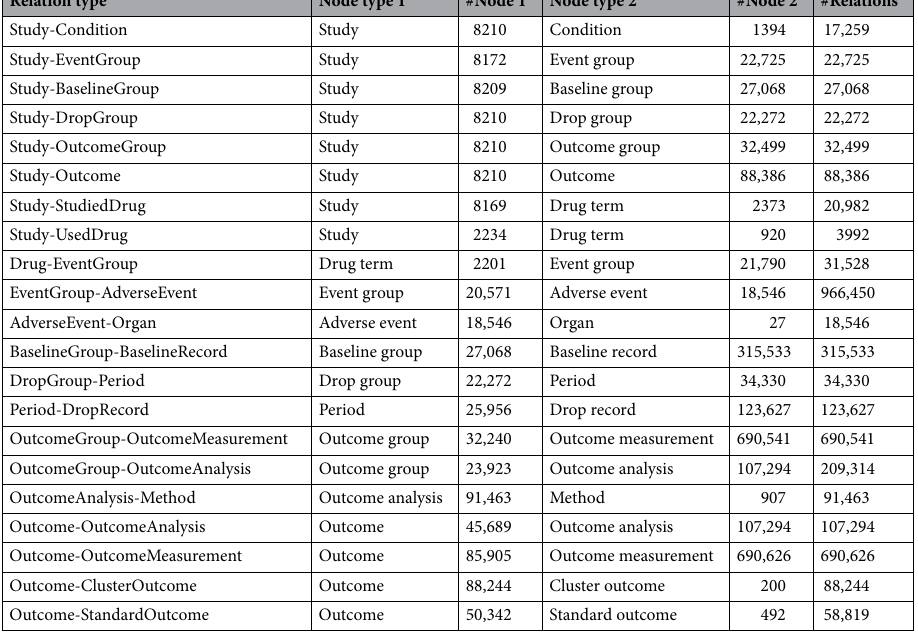
Table 2. Statistics of relation types in CTKG . Columns represent: “Relation type”: the type of relation; “Node type 1”: the type of head nodes in the relations; “#Node 1”: the number of unique head nodes with the relations; “Node type 2”: the type of tail nodes in the relations; “#Node 2”: the number of unique tail nodes with the relations; “#Relations”: the number of relations of a relation